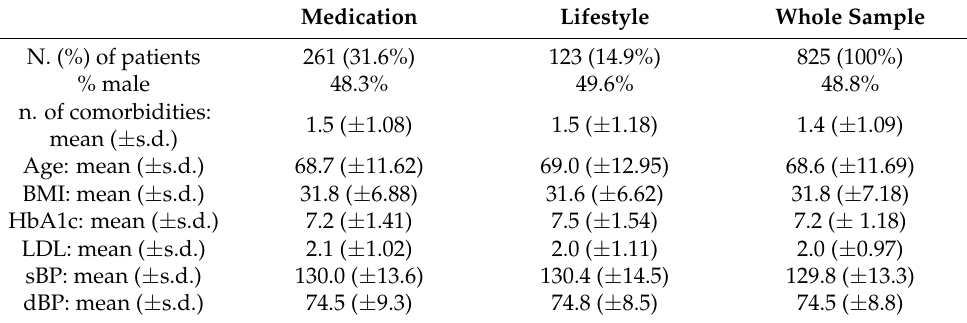
Table 1. Characteristics of medication and lifestyle patient segments. Medication Lifestyle Whole Sample N. (%) of